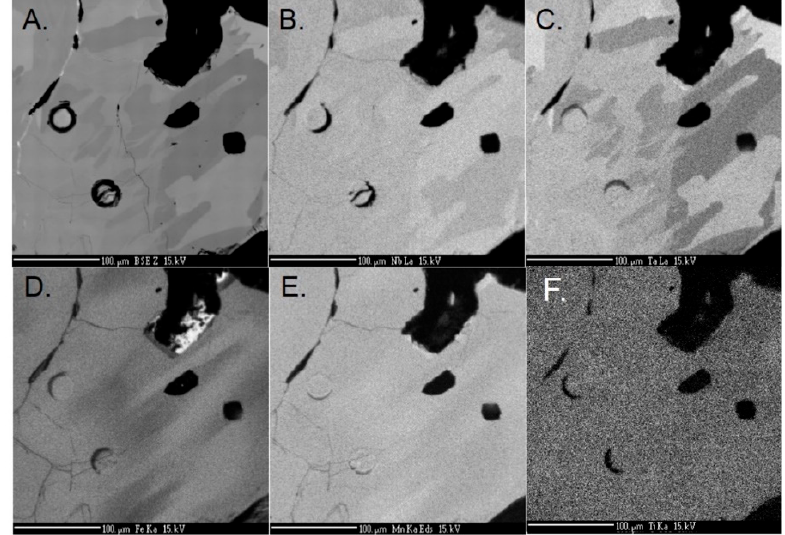
Figure 3. ( A ) Back-scattered electron image of columbite-(Mn) sample NYSM #525.7 from the corner of 185th Street and Harlem River Drive in New York City; X-ray maps: ( B ) Nb; ( C ) Ta; ( D ) Fe; ( E ) Mn; and ( F ) Ti. Field of view is 300 microns in each picture.